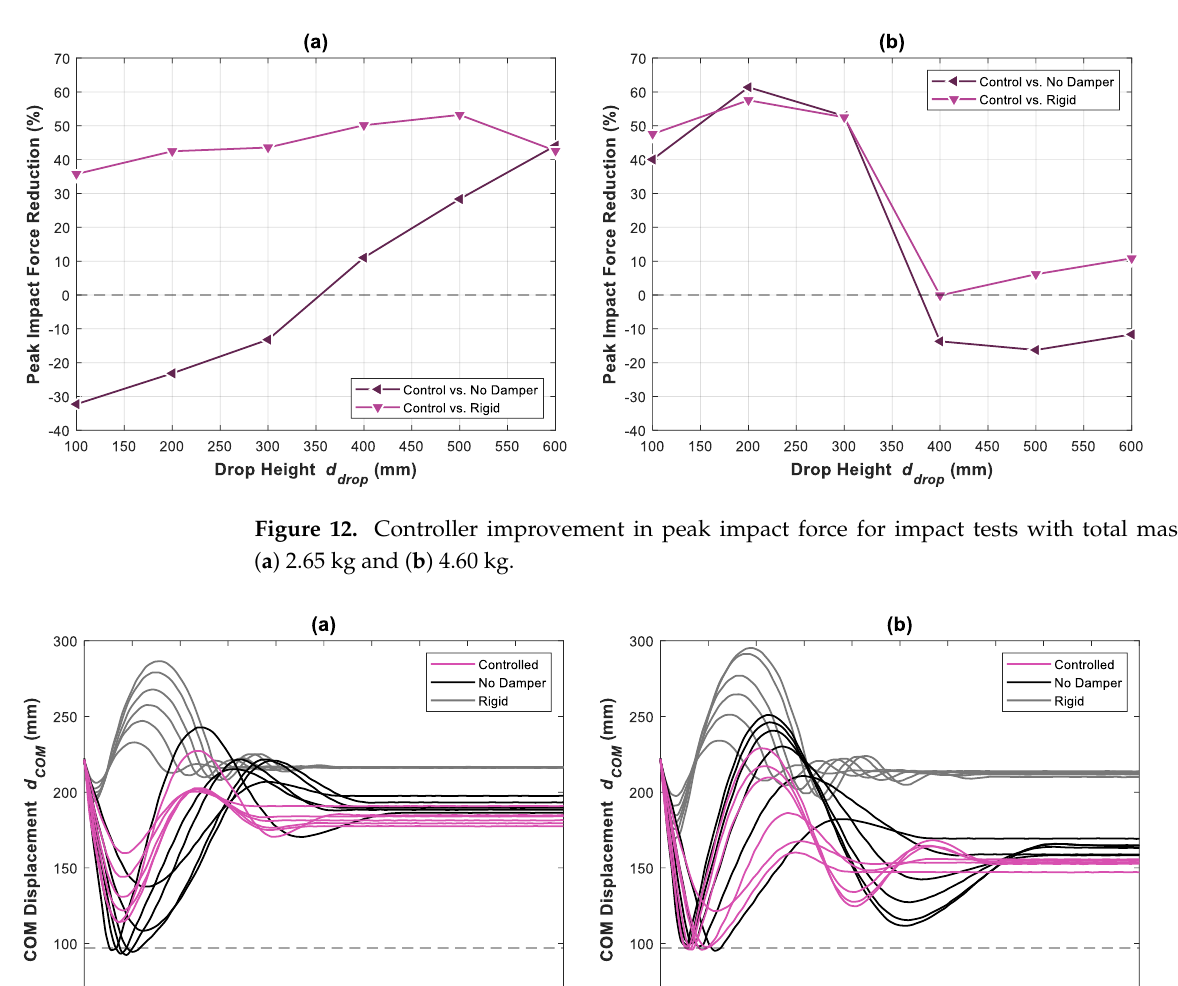
Figure 11. Controlled impact force for impact tests at all drop heights with total masses of ( a ) 2.65 kg and ( b ) 4.60 kg.